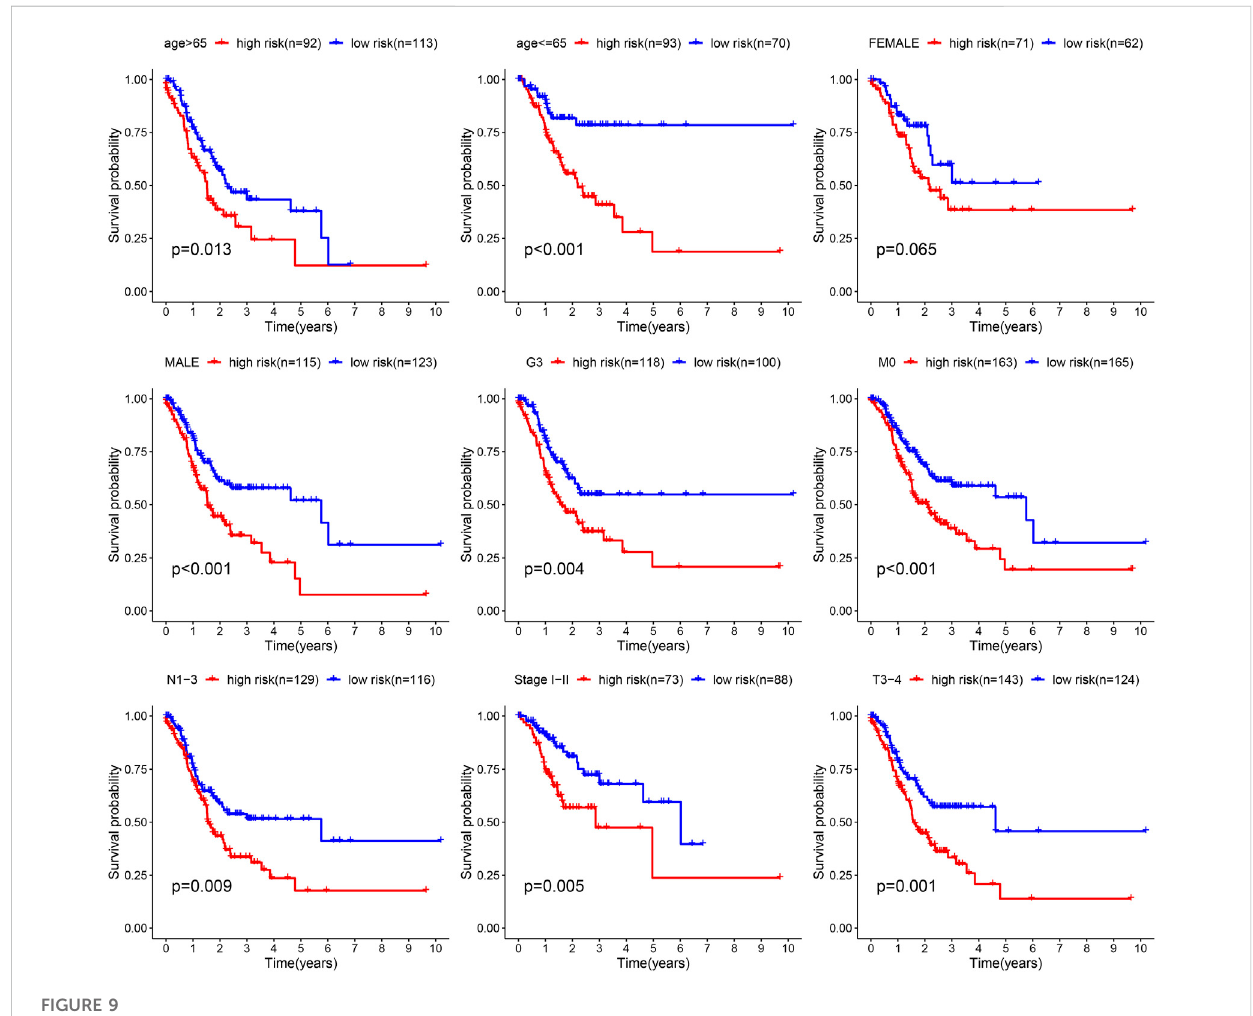
FIGURE 9 Survival differences of GC in different